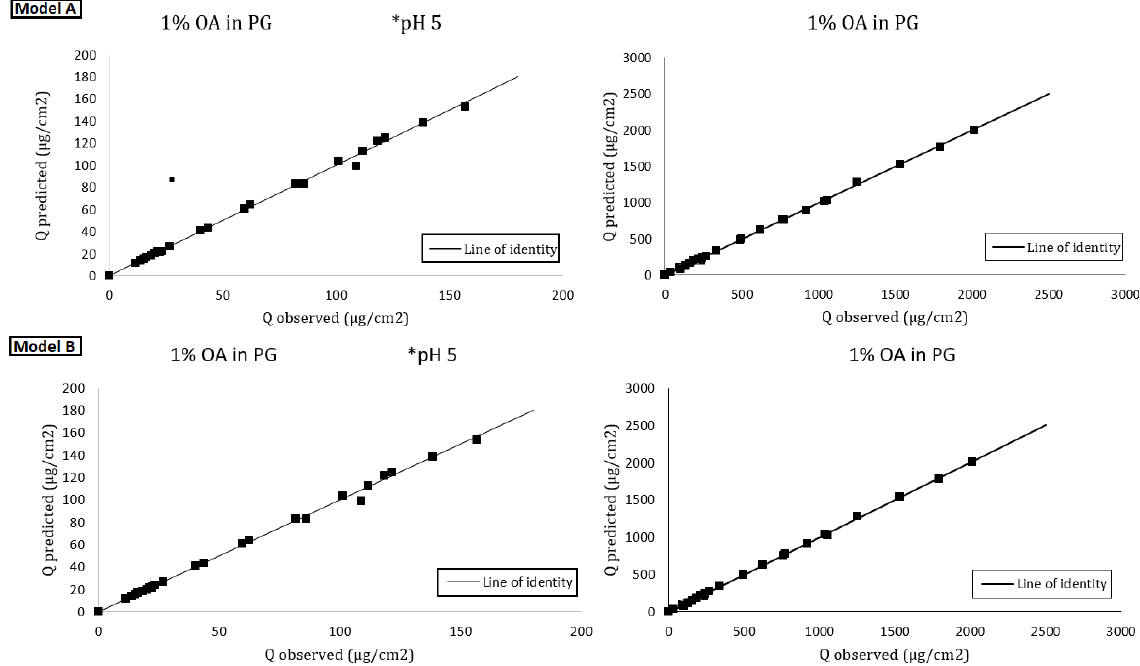
Figure 4. Goodness of fit (GOF) of transdermal transport of domperidone using 1% OA (oleic acid) in PG (propylene glycol) for pH of 5 (*) and pH of 1. The graph shown based on Q observed tranport versus Q predicted transport of domperidone; OA= oleic acid, PG= propylen glycol. The data were presented from the results of three replicates (*) and four replicates